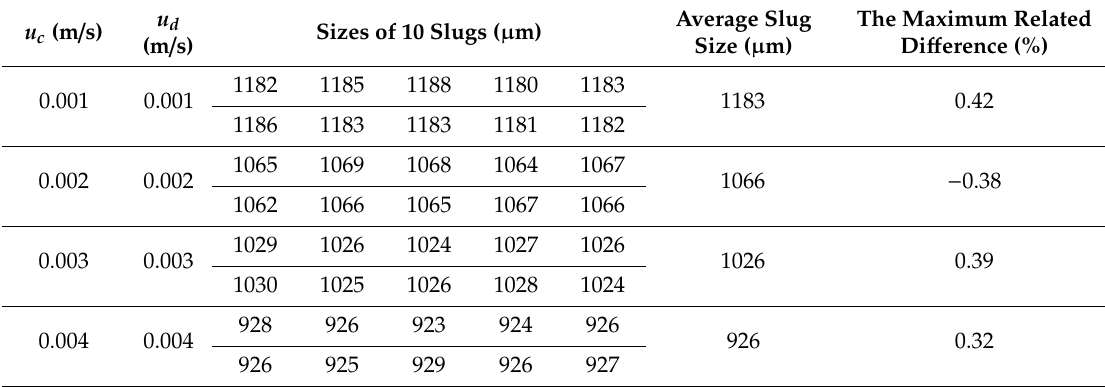
Table 2. The slug size of experiments.